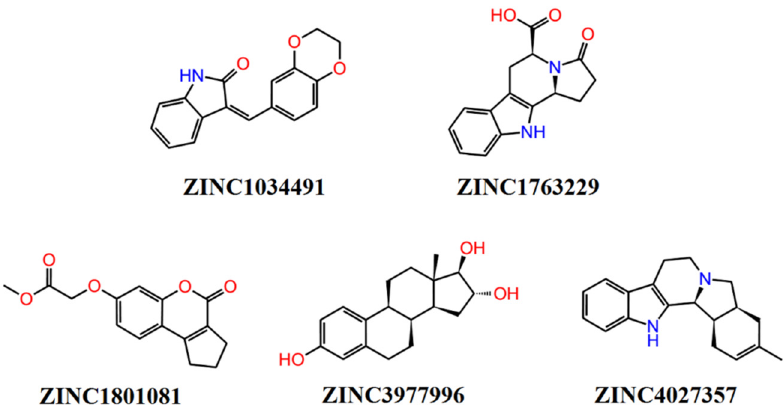
Figure 4. Structures of the selected compounds for biological experiments.